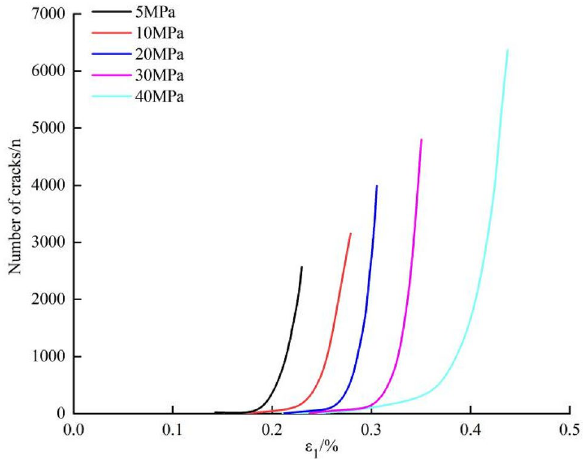
Figure 12. Crack number-strain curves during failure of the marble under different confining pressures.